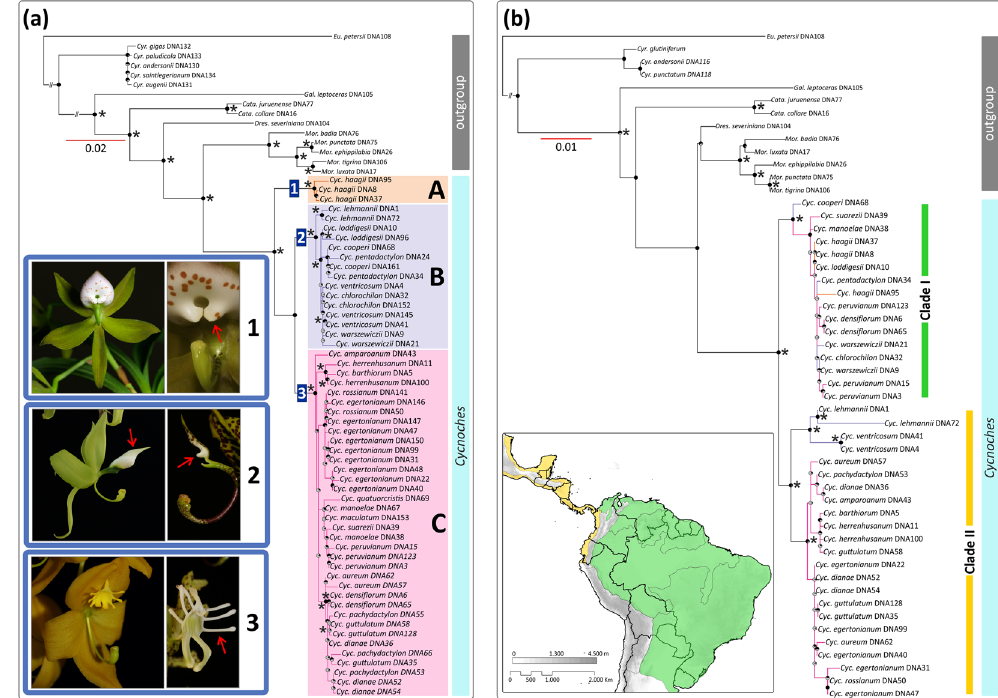
Figure 1. Best scoring ML tree of Cycnoches obtained from concatenated ( A ) nuclear ETS, ITS, Xdh and ( B ) plastid trn S– trn G, ycf 1. Node charts indicate Bootstrap Support (MLBS > 75), in where fully red diagrams indicate MLBS of 100. Numbers at nodes indicate Bayesian Posterior Probability (PP > 0.95). Representatives of each clade are shown in pictures: (1) C . haagii ; (2) C . ventricosum (left) and C . pentadactylon (right); (3) C . herrenhusanum (left) and C . peruvianum (right). The red arrows indicate apomorphies of every clade: in (1) fleshy oblong, curved pair set of calli located towards the base of the labellum, (2) labellum blade entire to 4-lobed, and (3) labellum with 8–10 marginal projections. Geopolitical boundaries map generated by ArcMAP software (http://www.esri.com), using layers freely available at http://www.diva-gis.org/Data. Photos: O. Pérez & G.